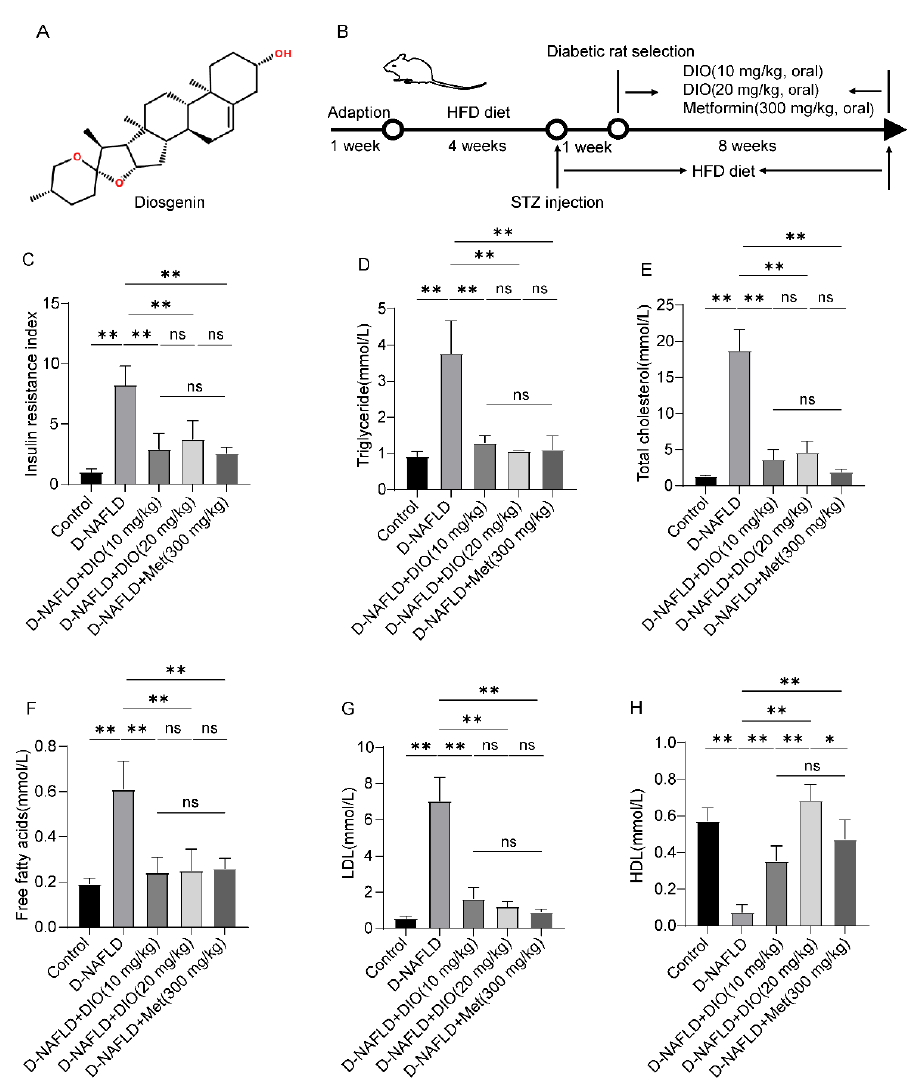
Figure 1. DIO reduced insulin resistance and improved dyslipidemia in D-NAFLD rats. ( A ) The structure of DIO. ( B ) Experimental design. ( C ) Insulin resistance index. ( D ) Serum triglyceride (mmol/L). ( E ) Serum total cholesterol (mmol/L). ( F ) Serum free fatty acids (mmol/L). ( G ) Serum LDL (mmol/L). ( H ) Serum HDL (mmol/L). n = 8 and the data were presented as mean ± SD. ns indicates no significance, * and ** indicate significant difference and highly significant difference, respec- tively.